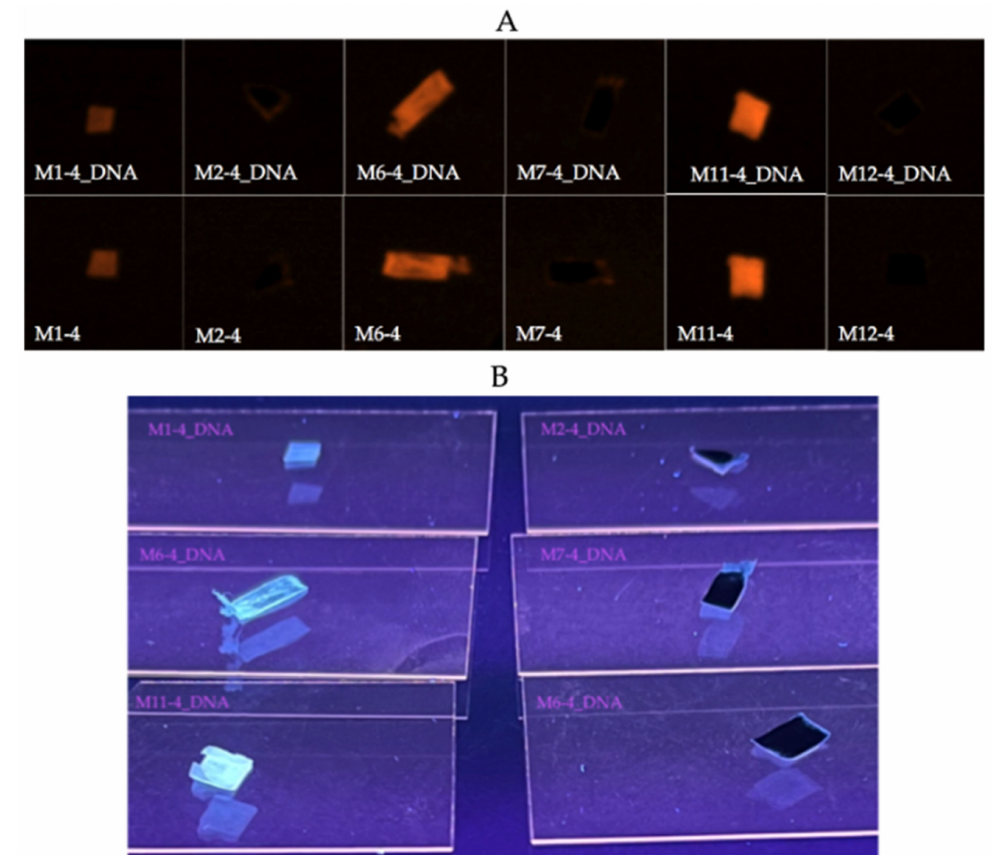
Figure 8. Ethidium bromide fluorescence boost upon binding to DNA before and after the treatment process (UVP GelSolo Transilluminator): ( A ) UV images of bare vs. DNA contaminated materials; ( B ) DNA contaminated materials visualized with their fluorescent bottom.